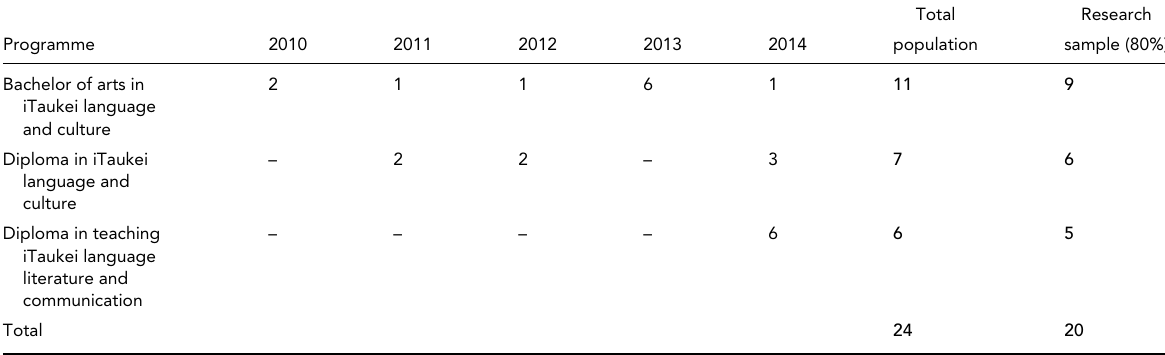
Student Population and Interview Research